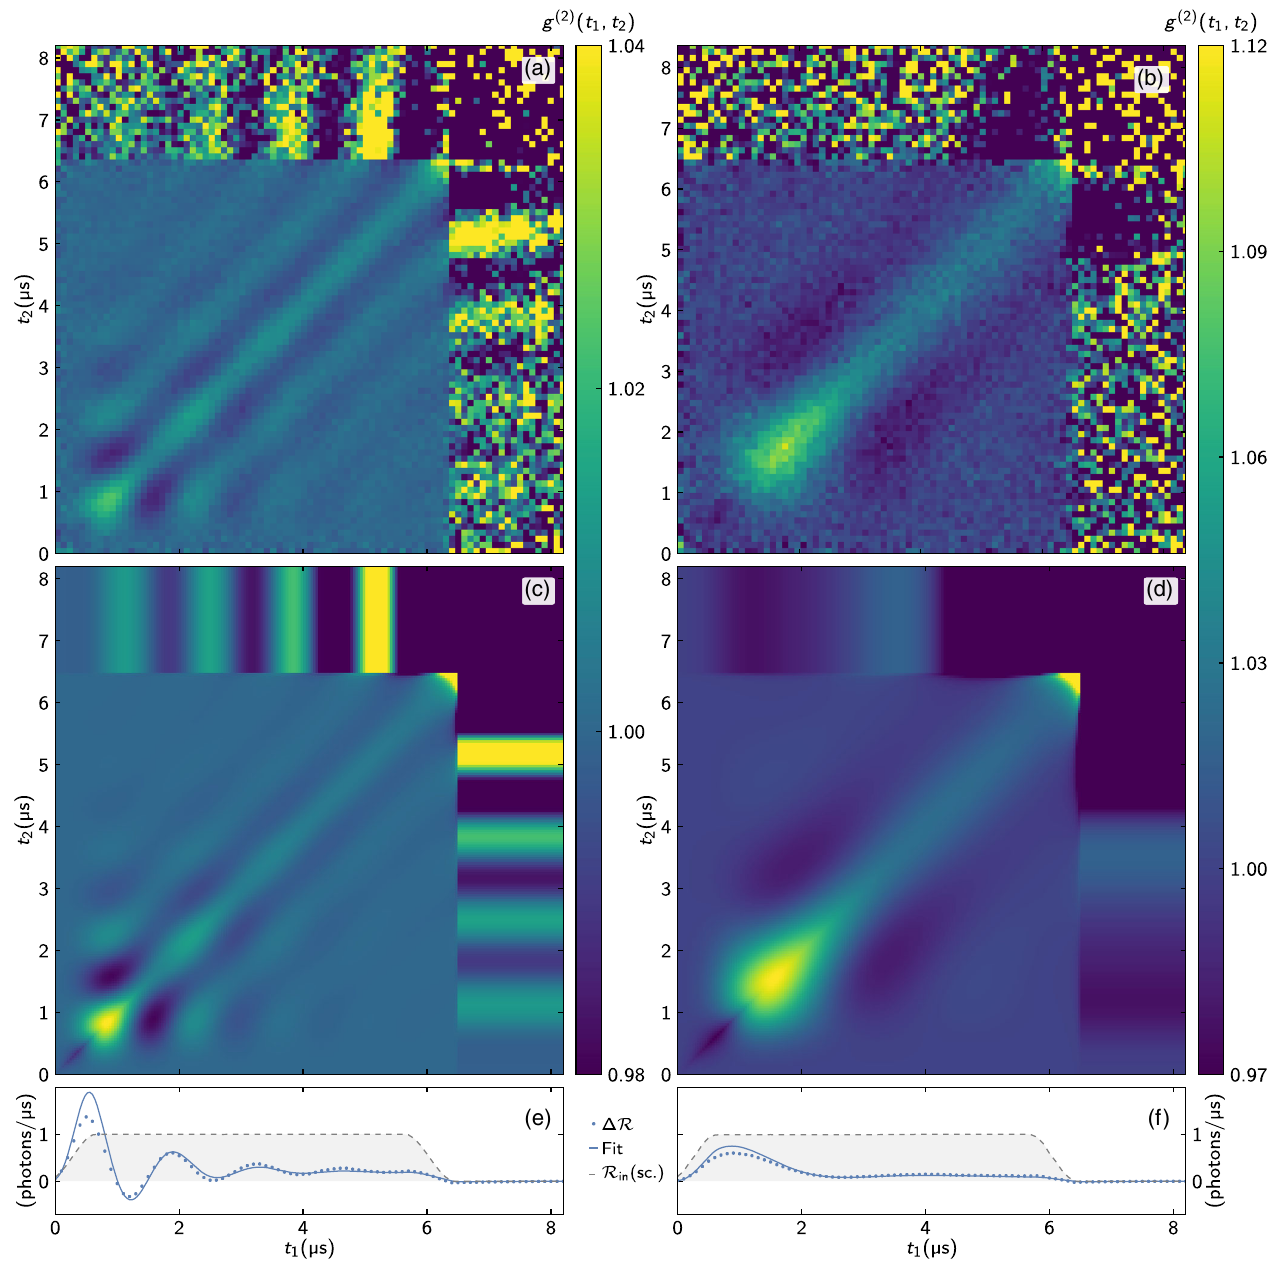
12 . 4 μ s − 1 and in ¼ in